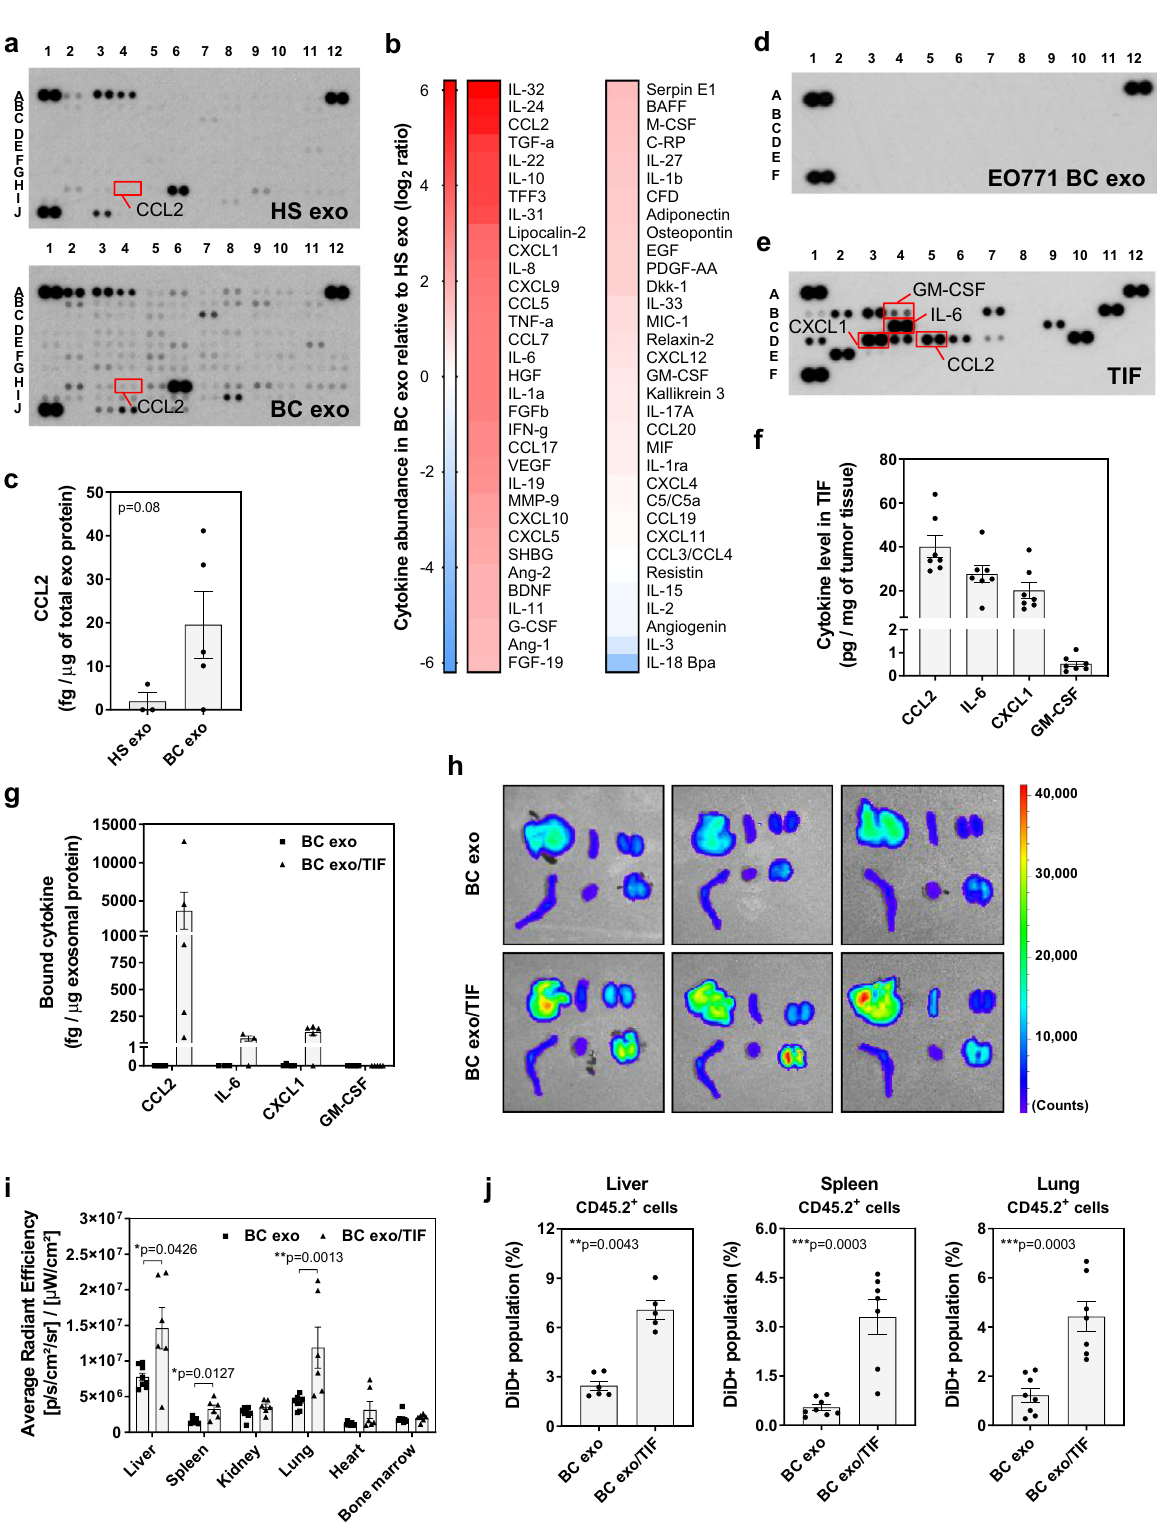
conjugated ones, with their spectra mainly plotted on the positive side of principal component 1 (PC1) (Fig. 4g). SERS detects alone, we observed that the positive peaks in PC1 that